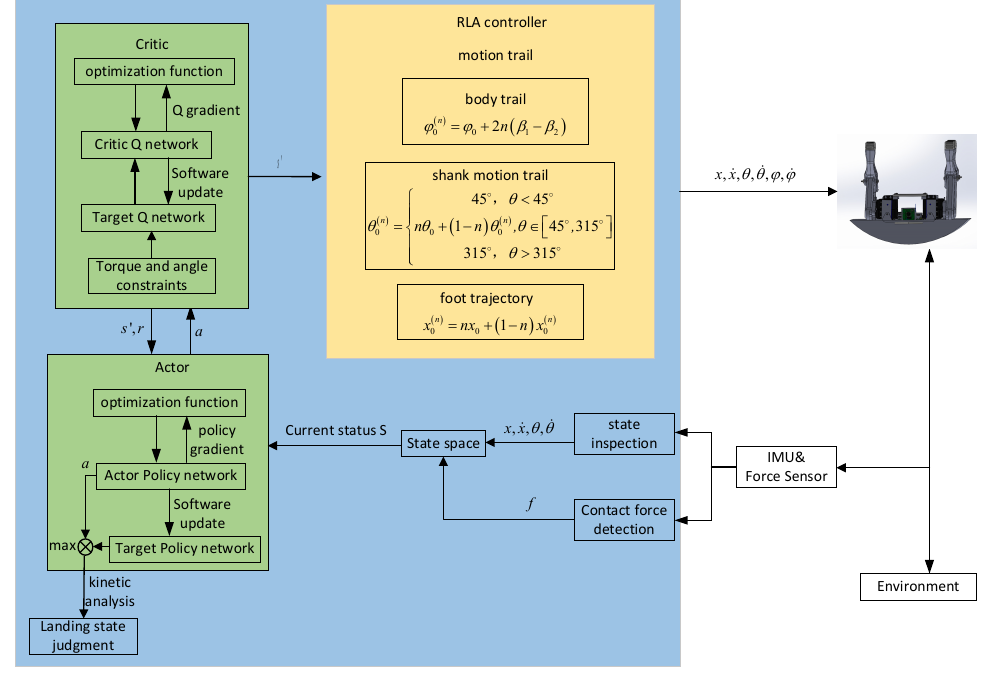
Figure 5. Implementation framework for DDPG control strategy.